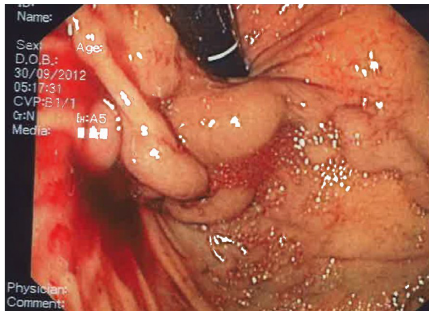
Figure 1: Endoscopic image of bleeding varices in the cardia and fundus.